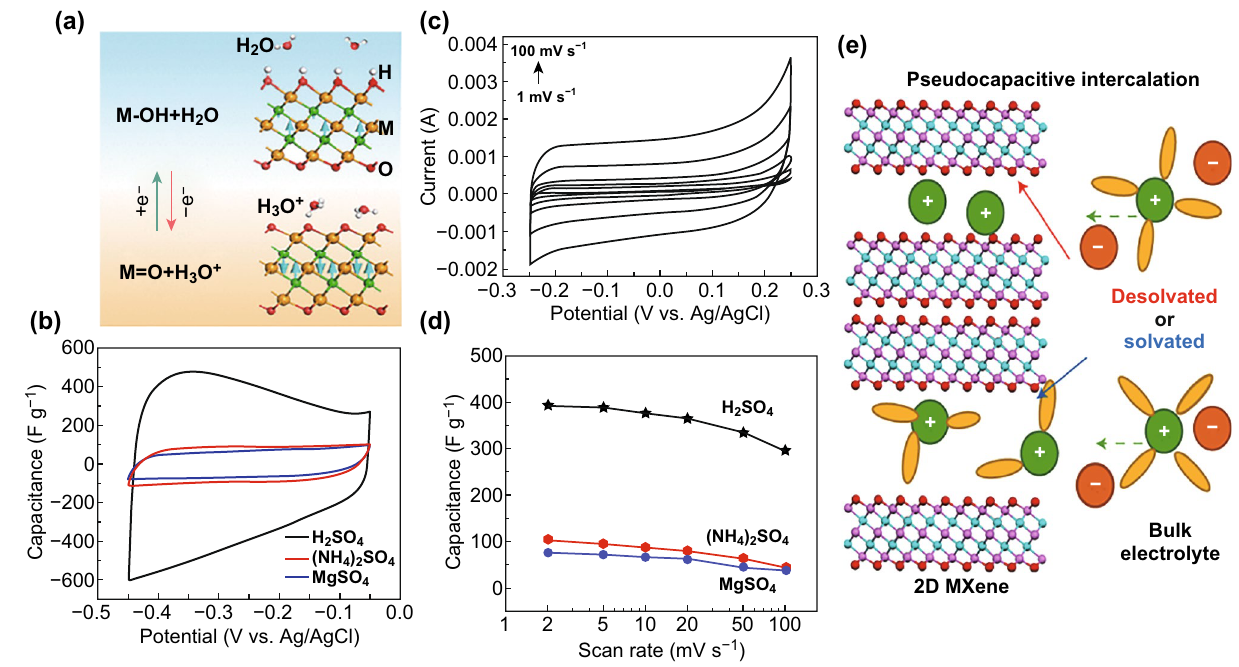
Fig. 4 Pseudocapacitance of Ti 3 C 2 T x in different electrolytes. a The change of surface group of Ti 3 C 2 T x in H 2 SO 4 [58]. b CV curves of Ti 3 C 2 T x at a scan rate of 20 mV s −1 [71]. c Gravimetric capacitances of Ti 3 C 2 T x at different scan rates [75]. d CV curves of Ti 3 C 2 T x at different scan rates in KOH electrolyte [75]. e Schematic of supercapacitor using Ti 3 C 2 T x (pink, Ti; cyan, C; red, O) as negative electrode with solvated or desolvated states. Legend for the electrolyte: green, cation; orange, anion; yellow, solvent molecule [81]. Reproduced with permission from Refs. [58, 71, 75, 81]. (Color figure